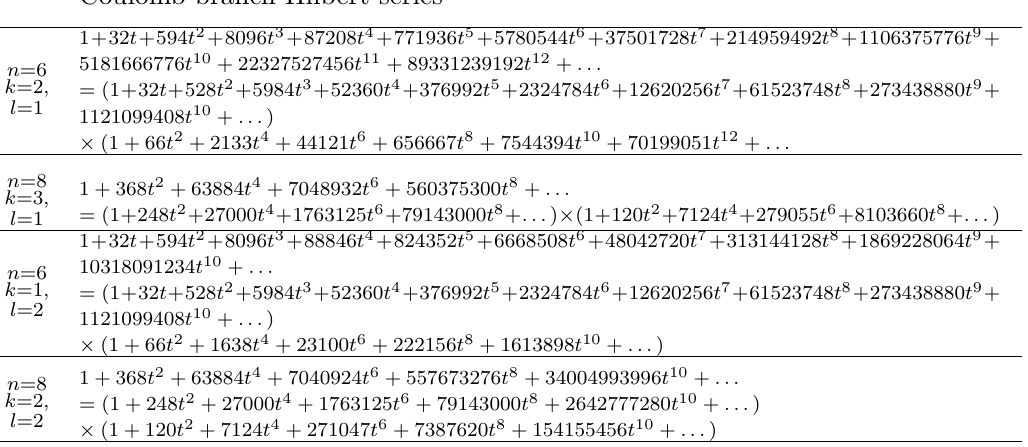
Table 11. Hilbert series results for (2.16). The first line displays the Coulomb branch Hilbert series for (2.16), while the second line displays the factorisation into a product. Each factor is consistent with the known Hilbert series for the individual theories in